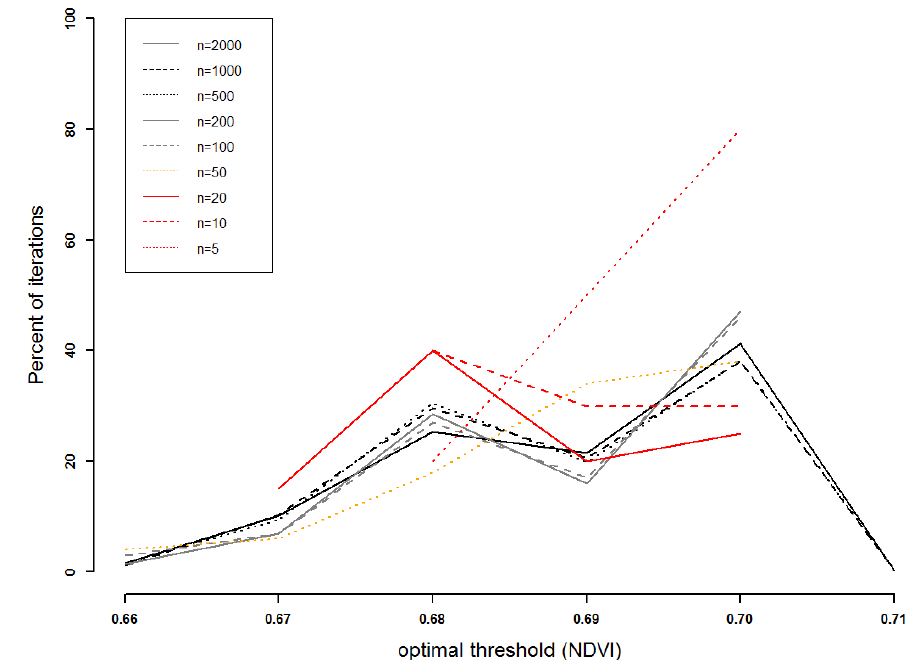
Figure 5. The approximation of the optimal threshold for the separation of forest types is depending on the number of iterations. A stabilization occurs for more than 100